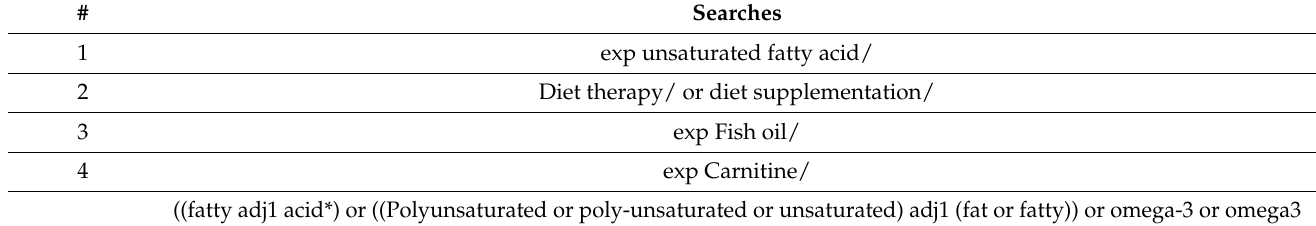
Table 2. Example of the search strategy in